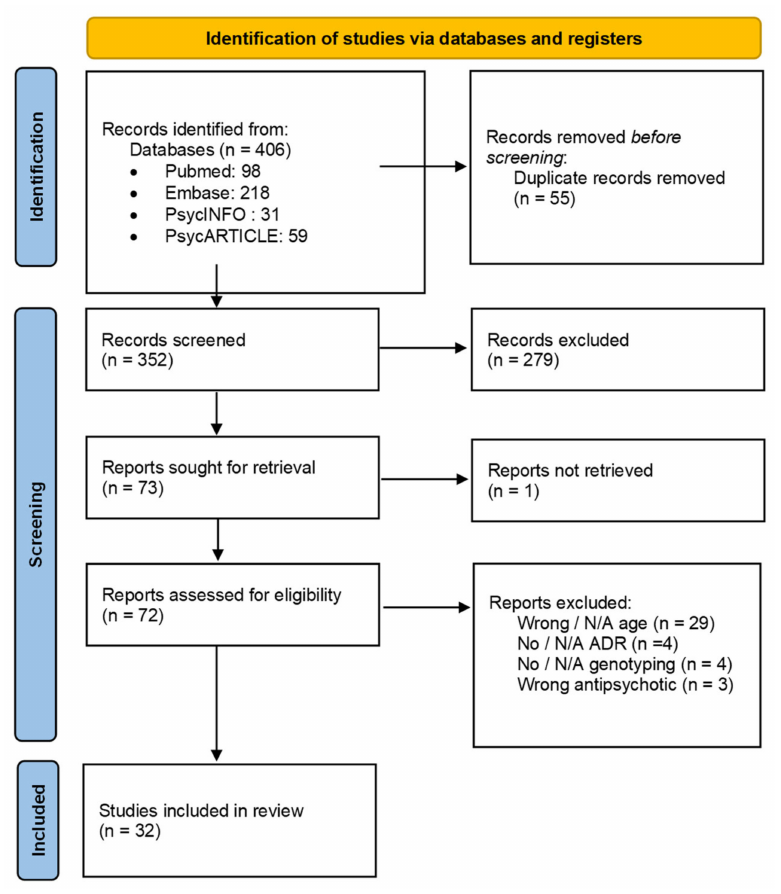
Figure 1. PRISMA 2020 flow diagram for identification of studies. N/A: Not applicable. From: Page MJ, McKenzie JE, Bossuyt PM, Boutron I, Hoffmann TC, Mulrow CD, et al. The